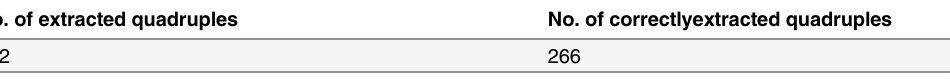
Table 10. Precision of the OpinionKB